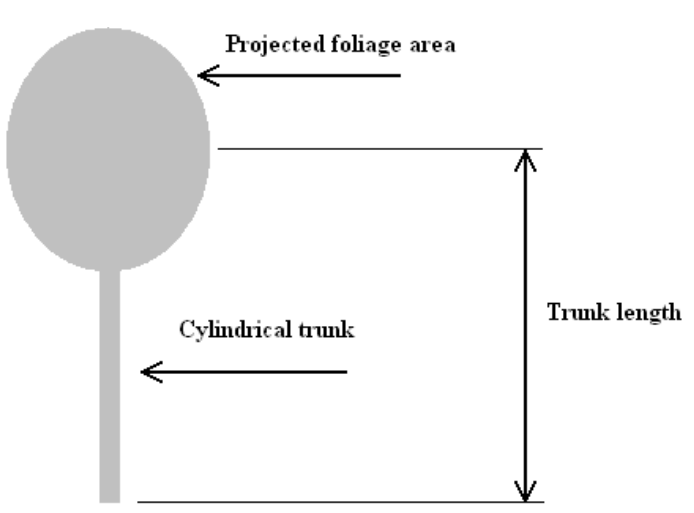
Figure 2. ‘Lollipop’ model of a